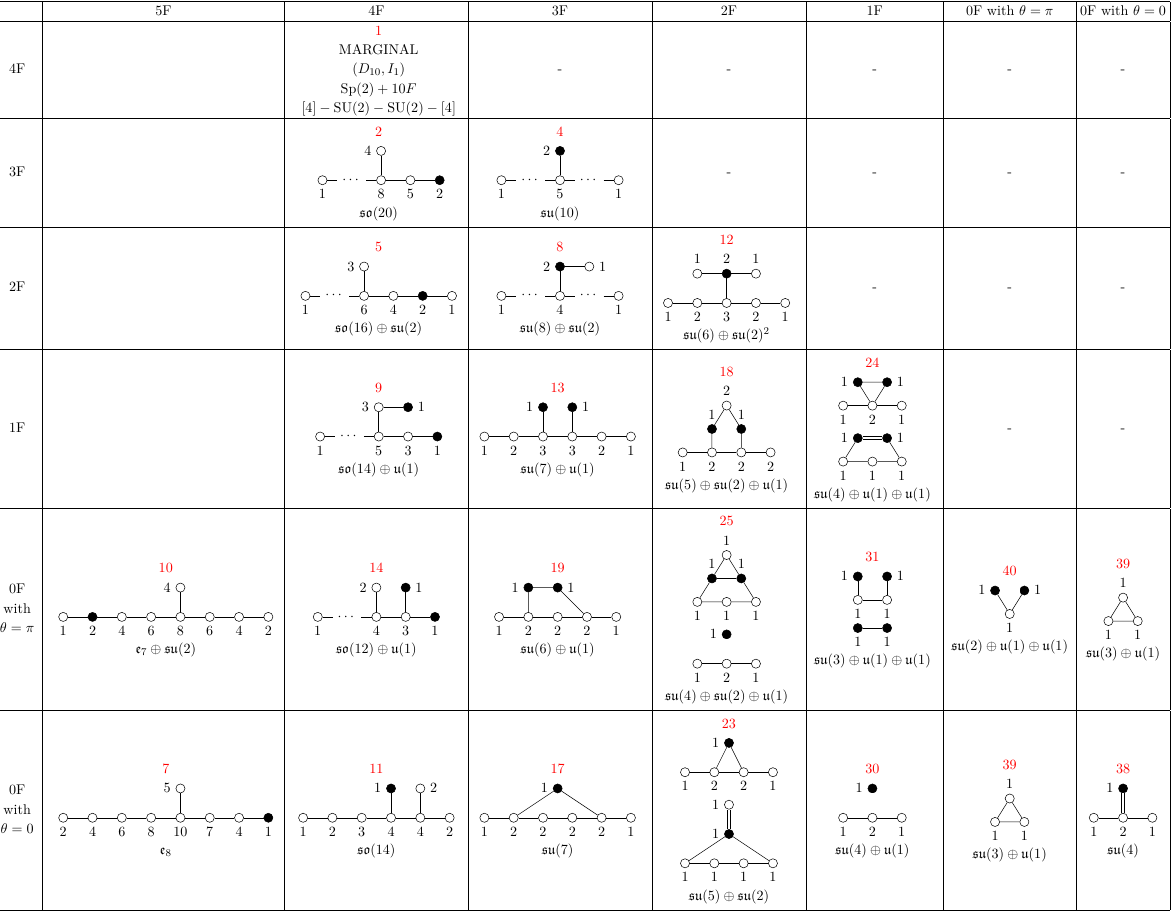
Table 10 . Rank 2 decoupling tree continued: magnetic quivers for 5d SCFTs with SU(2) − SU(2) quiver gauge theory IR description. The lines and columns correspond to the number of fundamentals on each gauge group. The dashes correspond to quivers which can be obtained from other boxes by flipping the electric